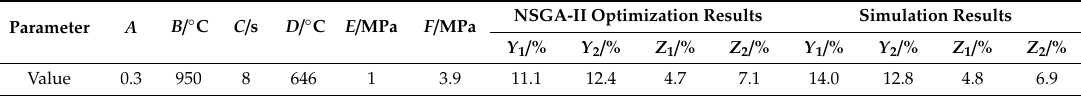
Table 6. Comparison of NSGA ‐ II optimization results and simulation results.